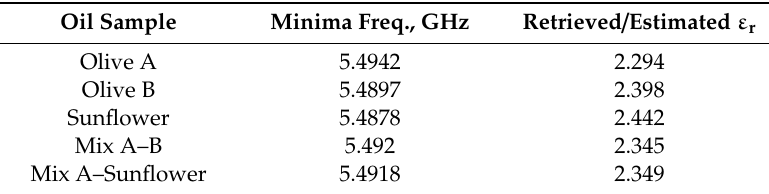
Table 2. Experimental data pertaining to the dielectric characterization of various oils and their mixtures.